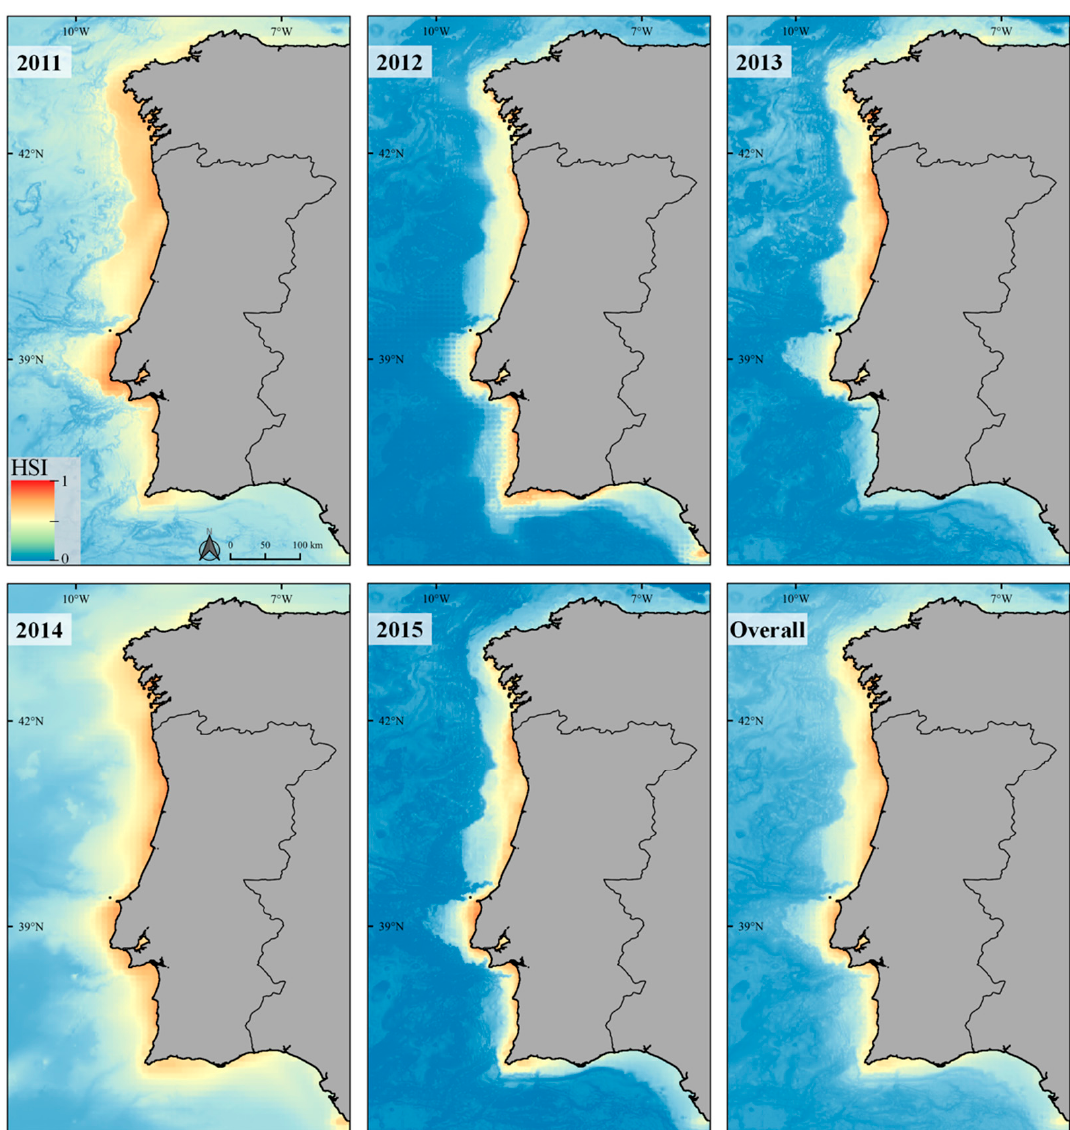
Figure 5. Annual and mean (overall) habitat suitability maps (considering the HSI) for the Harbour porpoise in the study area and the extent of the extrapolation area.